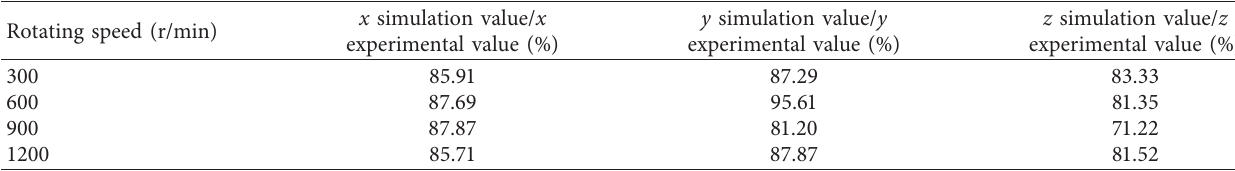
Figure 18: Comparison of experimental values and simulated values of axial vibration displacement at 1200r/min. Table 3: Ratio of simulated value to experimental value at different